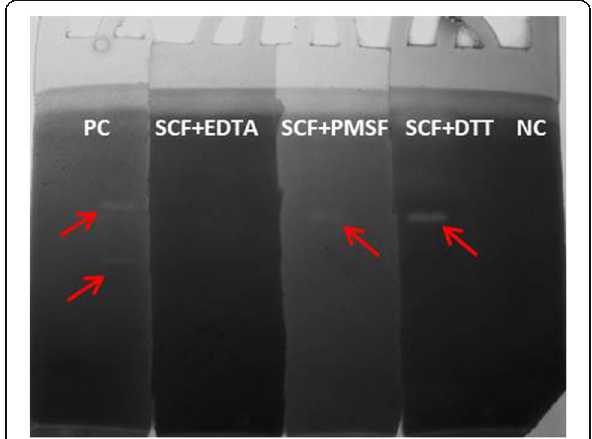
Fig. 6 Inhibition of fibrinogenolytic activity of SCF using zymogram protease assay. Arrows in red indicate zones of digestion of fibrinogen as substrate. SCF (4 μ g/ml) was treated with protease inhibitors PMSF, EDTA, and DTT for 2 h and fibrinogenolytic activity of treated SCF was estimated post incubation. PC is positive control (untreated SCF), NC is negative control (20 mM KPB). Fibrinogenolytic activity was inhibited upon incubation of SCF with